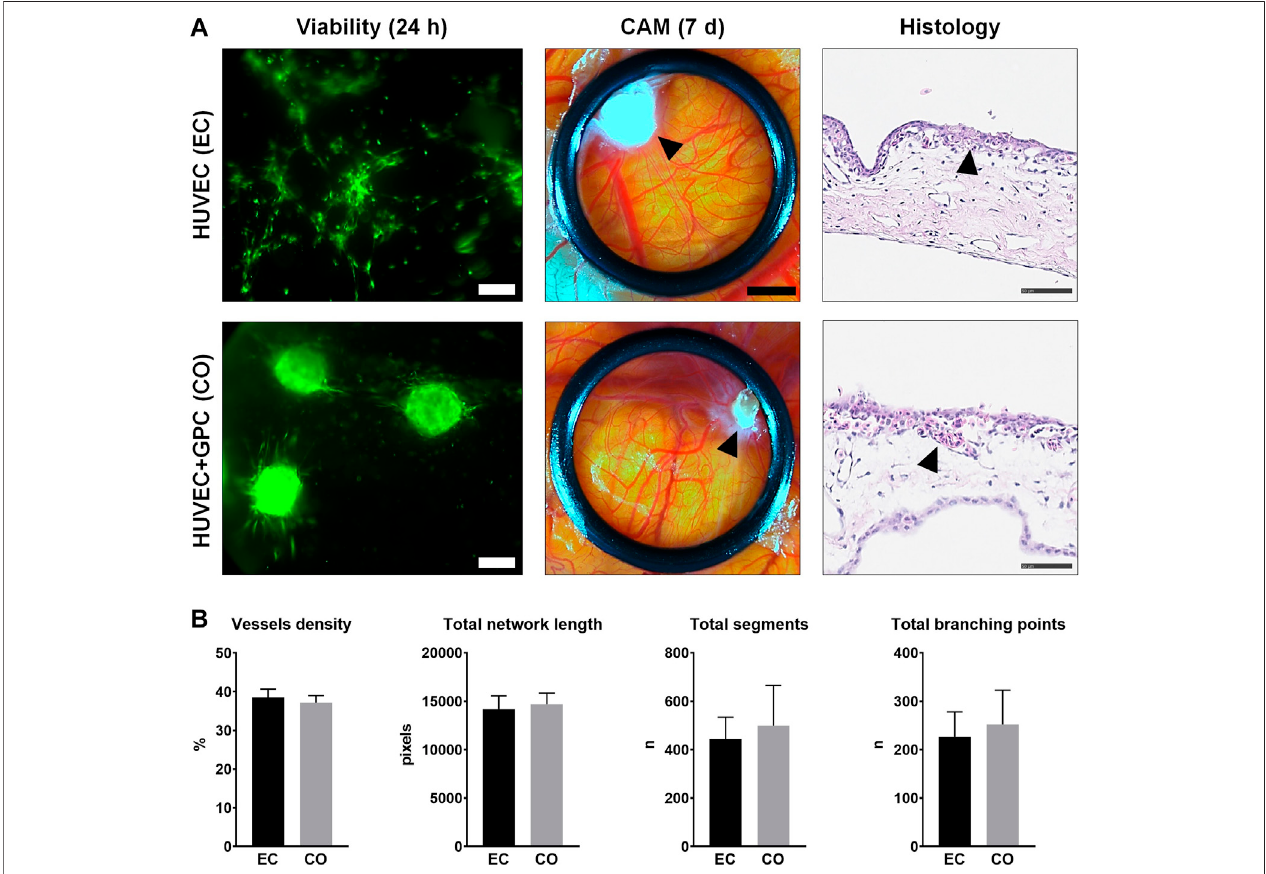
FIGURE 6 | CAM angiogenesis assay. (A) Comparison of HUVEC (EC) and HUVEC-GPC coculture (CO) spheroids seeded in HPLG (L to R): cell viability after 24 h [green colour indicates viable cells, note the dissociation of HUVEC (EC) spheroids into tube-like networks; scale bars 100 μ m], stereomicroscope images showing neoangiogenesisinCAMsafter7 days(blackarrowsindicatecondensedHPLGwithintheO-rings;scalebars200 μ m)andcorrespondinghistologicalimageswithH&E staining (black arrows indicate newly formed vessels; scale bars 50 μ m). (B) Analysis of angiogenesis-related parameters based on stereomicroscope images; n (cid:2) number; data represent means ± SD (n (cid:2)